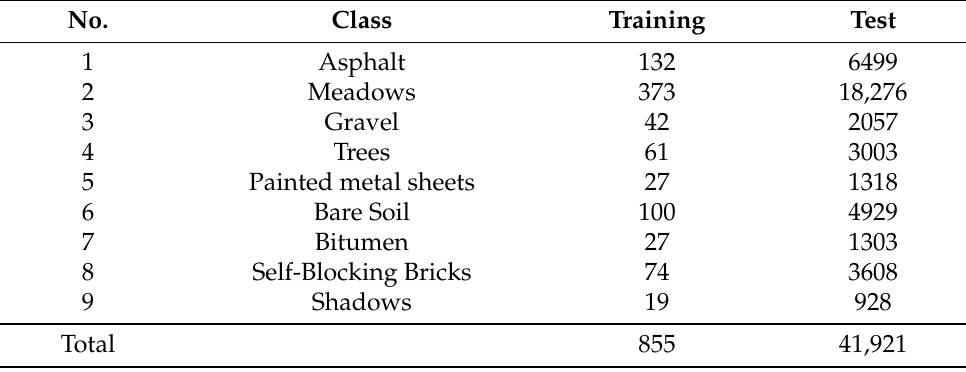
Table 2. Training and testing data in the PaviaU data set.